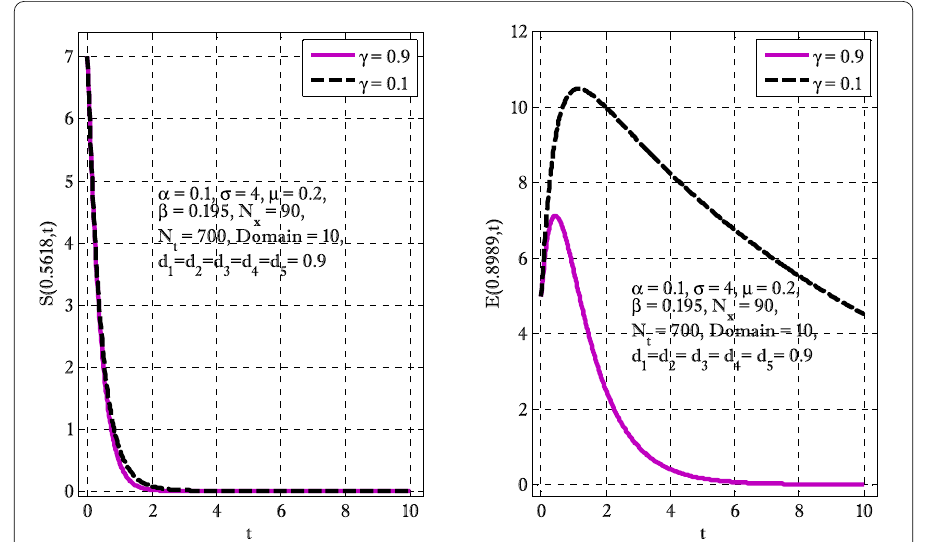
Figure 1 Susceptible and exposed individuals with the variation of conversion rate γ